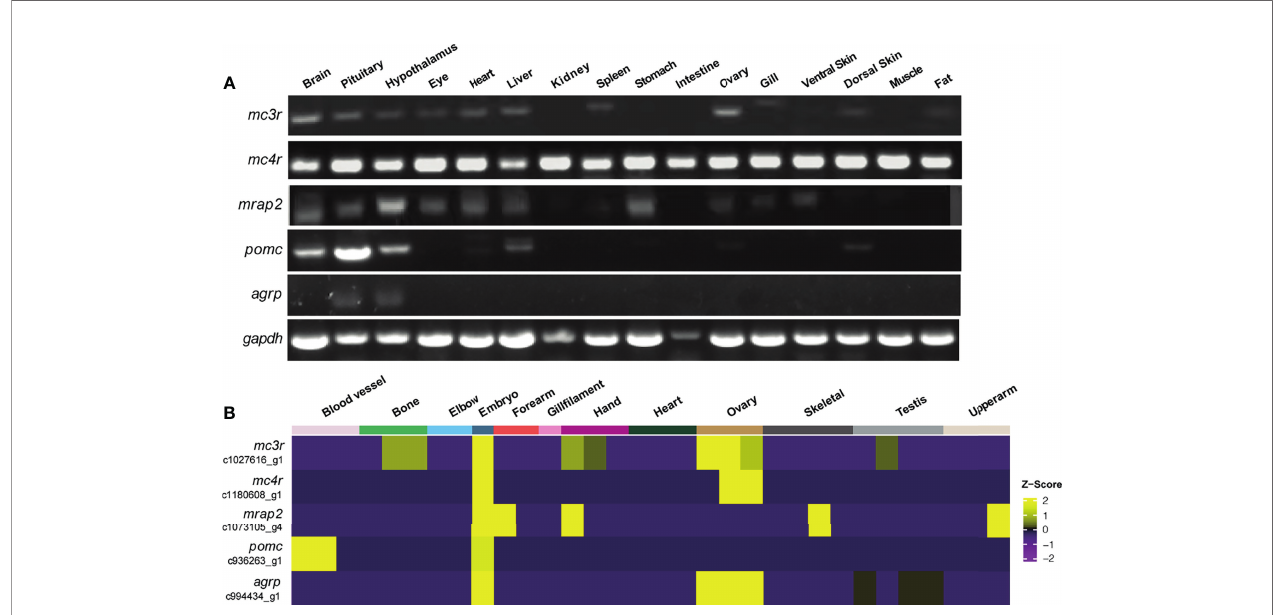
FIGURE 4 | Tissue distribution of mc3r , mc4r , mrap2 , agrp , and pomc mRNA in axolotl. (A) Tissue expression of mc3r , mc4r , mrap2 , agrp , and pomc mRNA was analyzed by semi ‐ quantitative reverse transcription PCR using a housekeeping gene glyceraldehyde 3-phosphate dehydrogenase ( gapdh ) as the internal control. (B) Heatmap showing the corresponding transcripts of mc3r , mc4r , mrap2 , agrp , and pomc enriched in speci fi c tissue